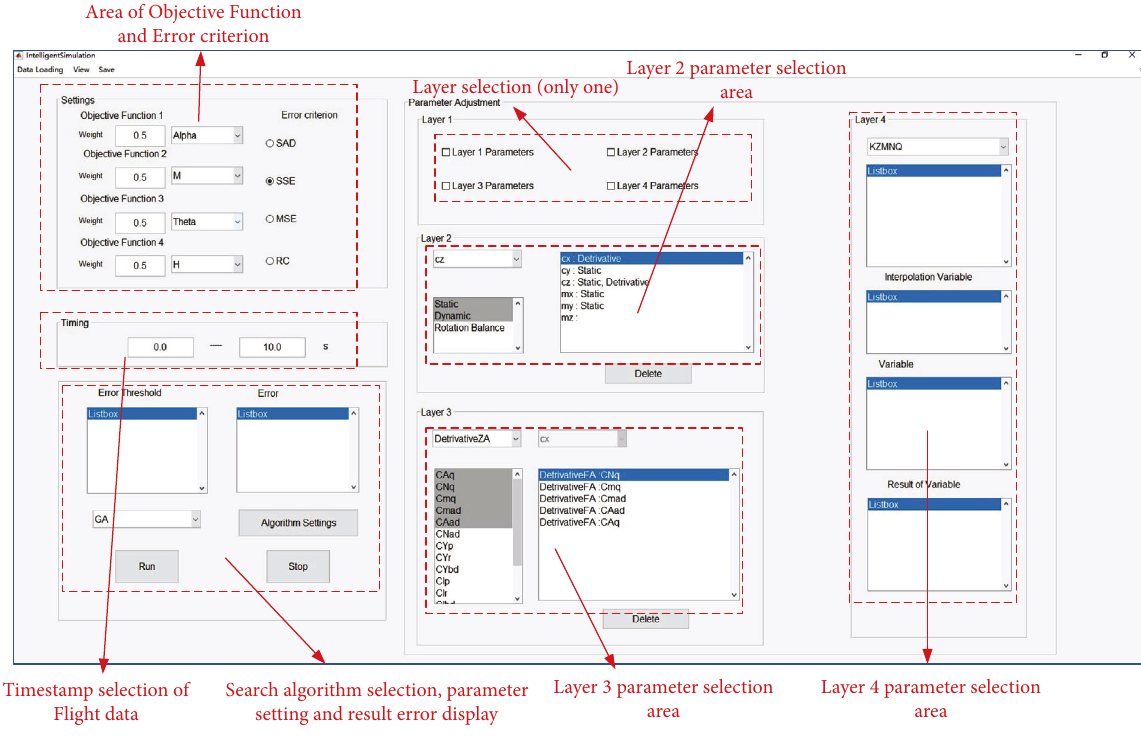
Figure 9: The illustration of the interface of the developed homology comparison intelligent optimization